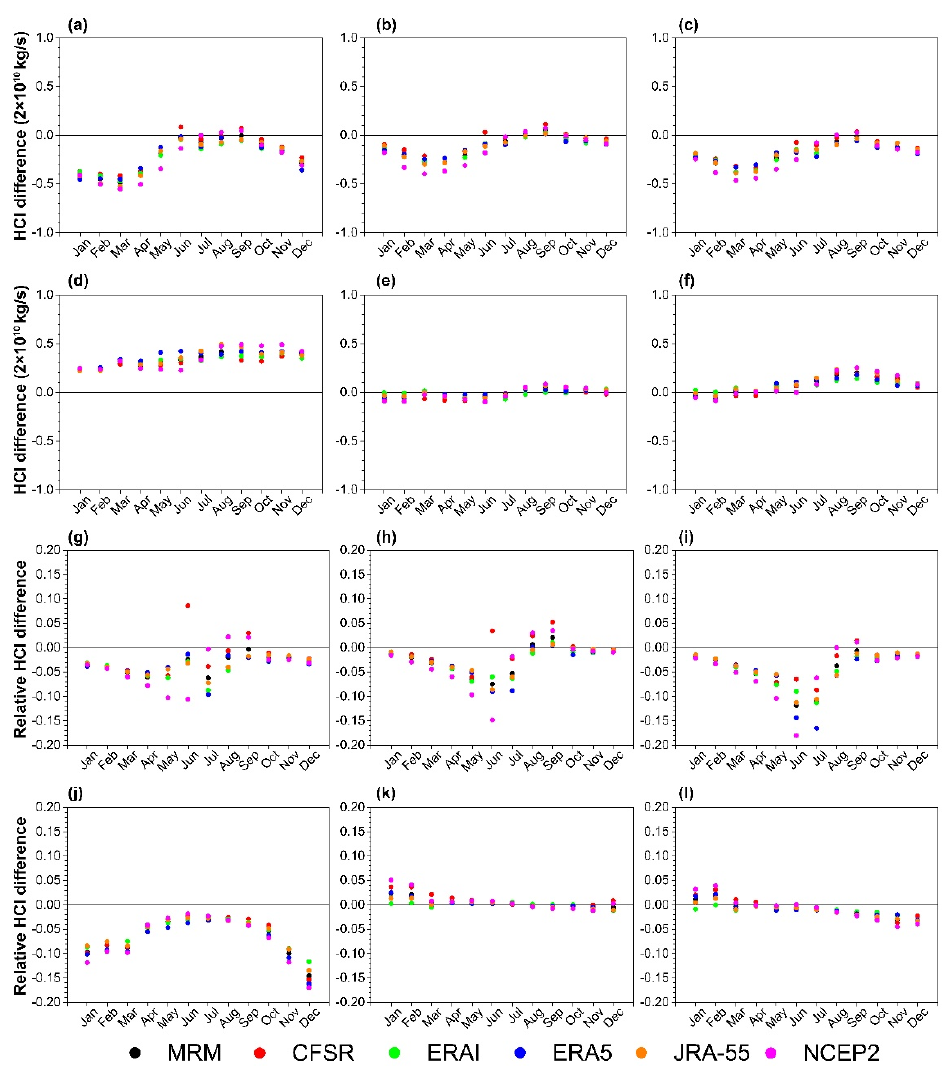
Figure 7. ( a – c ) Annual cycle of the di ff erence between the uncorrected and corrected NH HCI derived from ( a ) M1, ( b ) M2, and ( c ) M3 using the MRM (black), the Climate Forecast System Reanalysis (CFSR) and CFSR Version 2 (hereafter CSFR; red), the European Centre for Medium-Range Weather Forecast (ECMWF) Interim Reanalysis (hereafter ERA-Interim; green), the fifth generation of ECMWF atmospheric re-analyses of the global climate (hereafter ERA5; blue), the Japanese Meteorological Agency 55 year Reanalysis (hereafter JRA-55; orange), and NCEP2 (magenta) data sets from 1979–2018. ( d – f ) Same as ( a – c ) but for the annual cycle of the di ff erence between the uncorrected and corrected SH HCI. ( g – i ) Same as ( a – c ) but for the annual cycle of the relative di ff erence between the uncorrected and corrected NH HCI (i.e., the di ff erence divided by the mean value of the corrected NH HCI). ( j – l ) Same as ( g – i ) but for the annual cycle of the relative di ff erence between the uncorrected and corrected SH HCI. The units for the HCI di ff erence are 2 × 10 10 kg /